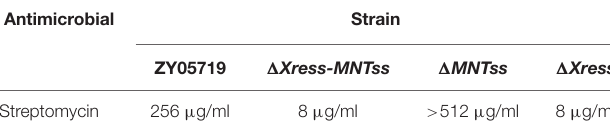
TABLE 3 | The MICs of strain to Streptomycin.